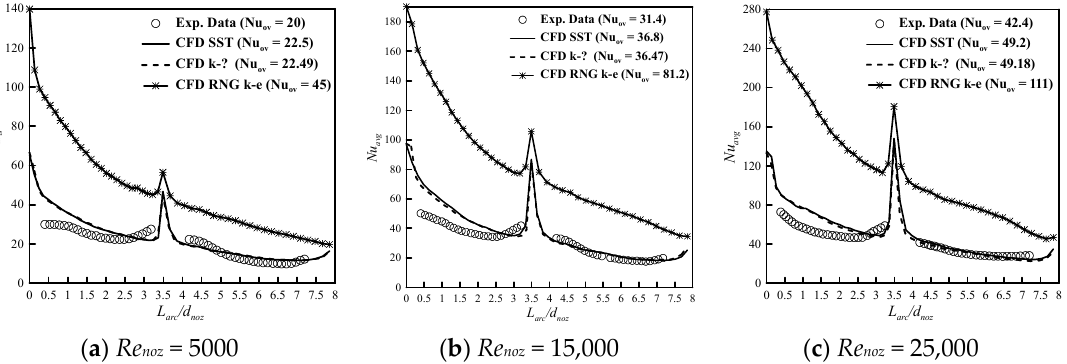
Figure 5. Spanwise averaged Nusselt number for both experimental and numerical results of swirl cooling at ( a ) Re noz = 5000, ( b ) Re noz = 15,000 and ( c ) Re noz = 25,000.